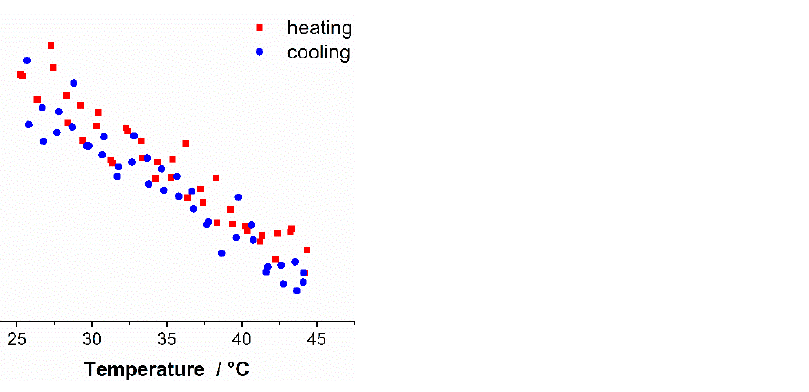
Figure 9. Hydrodynamic radii evolution of P(DMA 35 -NIPAM 212 )-PS 1089141 (c = 0.02% ( w / w )) as a function of temperature determined by DLS measurements. The red dots represent the hydrodynamic radii during the heating of the polymer dispersion and the blue dots represent the corresponding hydrodynamic radii during the cooling step. The LCST of the copolymer precursor P(DMA 35 -NIPAM 212 ) 28 is 42 °C, as determined by DLS measurements.